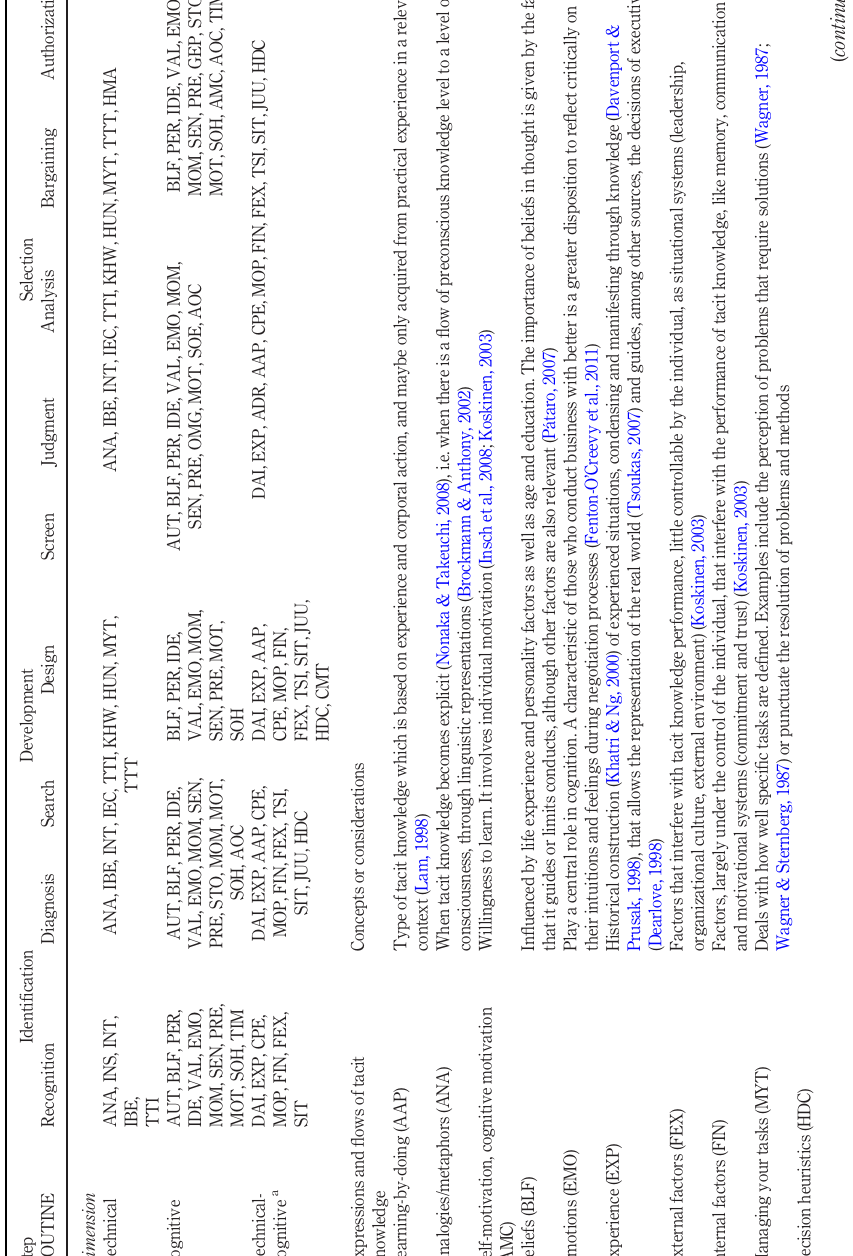
Table I. Possible expressions and prevalent flows of tacit knowledge at the